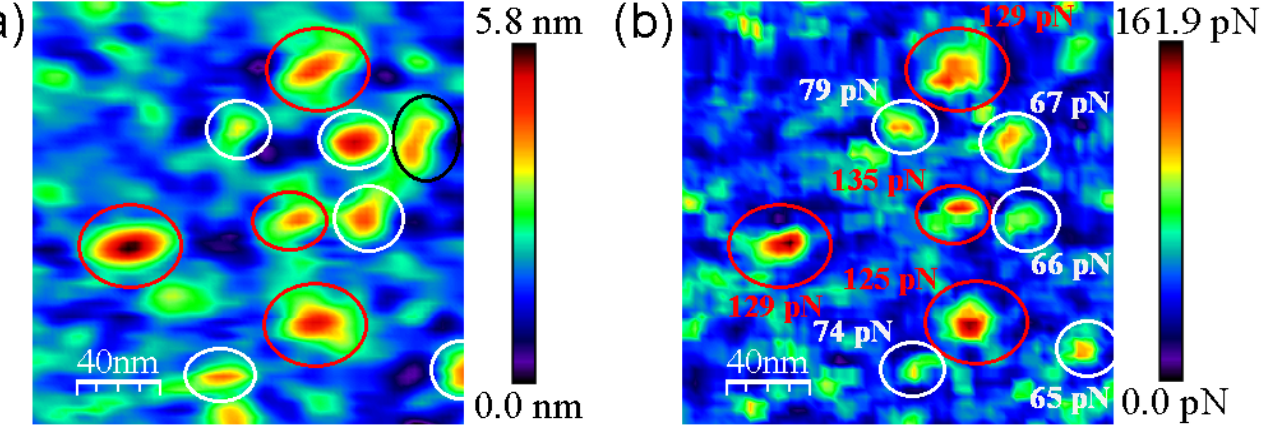
Figure 6. Representative molecular recognition images for the hybrid mixture of strept(avidin) pro- teins. Topography ( a ) and adhesion ( b ) maps given by scanning with biotinylated tips. Individual avidin and streptavidin protein molecules identified through the unbinding forces of the corre- sponding complexes with biotin displayed in ( b ) are shown in white and red, respectively. Non- identified protein features are shown in black circles. Scan size is 200 nm × 200 nm.